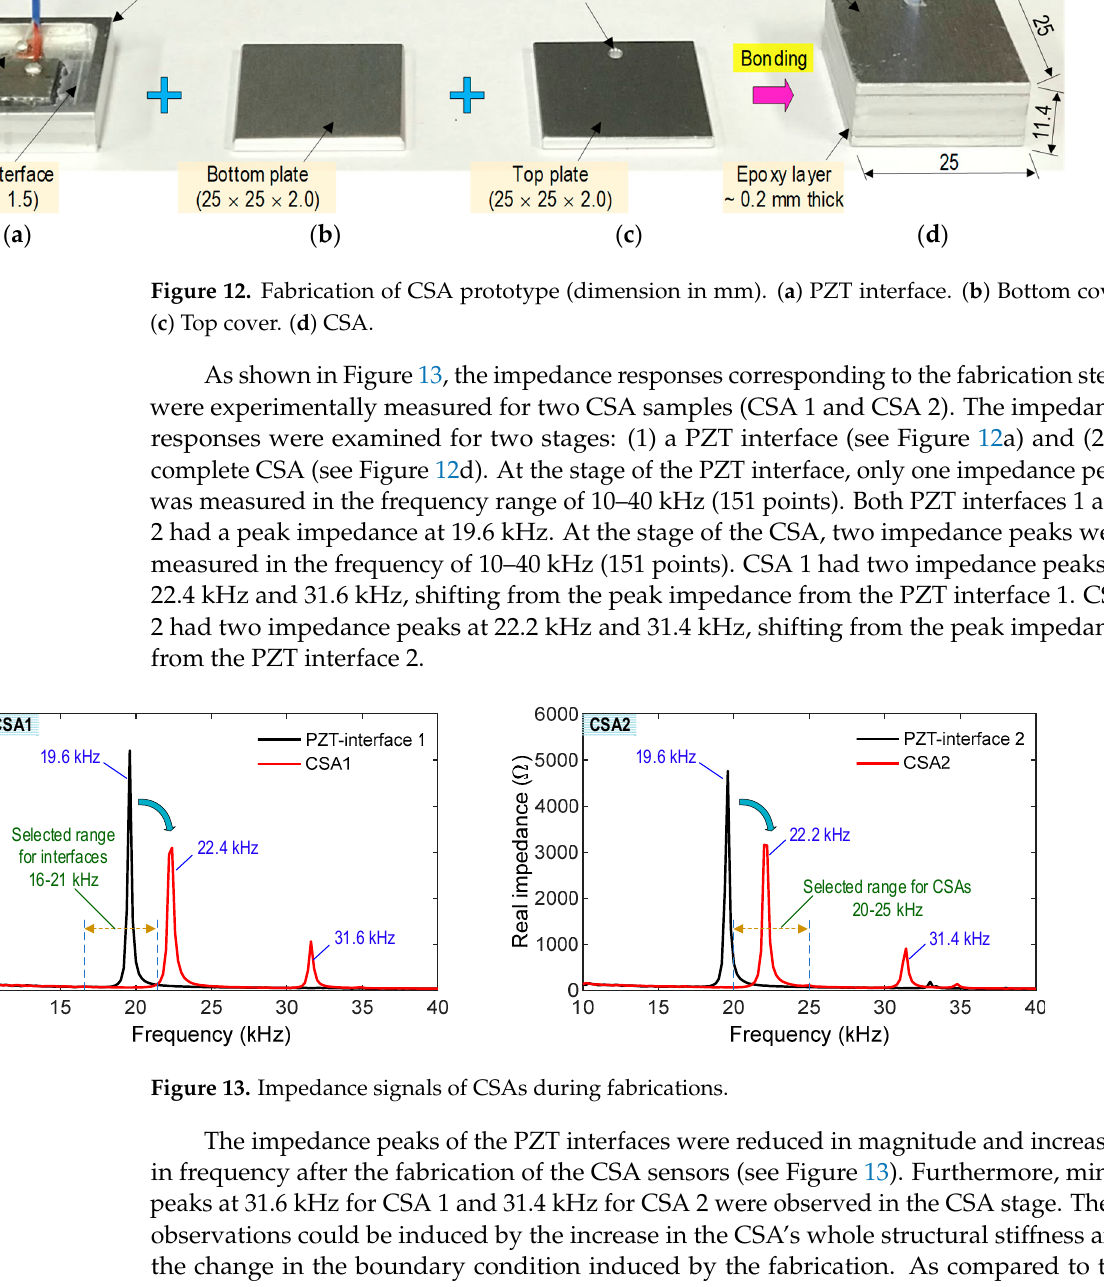
( b ) Figure 11. Numerical correlation estimation between CCD index and compressive stress. ( a ) z-di- rectional loading. ( b ) x-directional loading. 4. Experimental Impedance Analysis of CSA under Compression 4.1. Fabrication of CSA Prototype The CSA prototype was fabricated by assembling its components. Figure 12 shows the fabrication process of the CSA sensor that was selected based on the numerical analy- sis described previously. As shown in Figure 12, a PZT 5A patch (10 × 10 × 0.51 mm) was connected to electric wires, and it was surface-mounted on an aluminum vibrating plate (21 × 21 × 1.5 mm). The vibrating plate was positioned at the center of an aluminum wall frame (thickness of 2 mm and height of 7 mm) to form a PZT-mounted interface (see Fig-